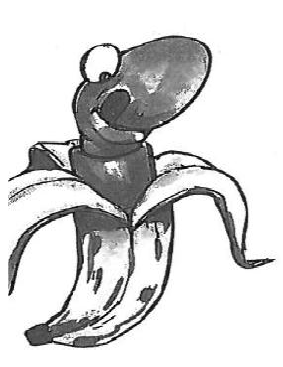
Figure 8: Uncaptioned picture Figure 9: Uncaptioned picture